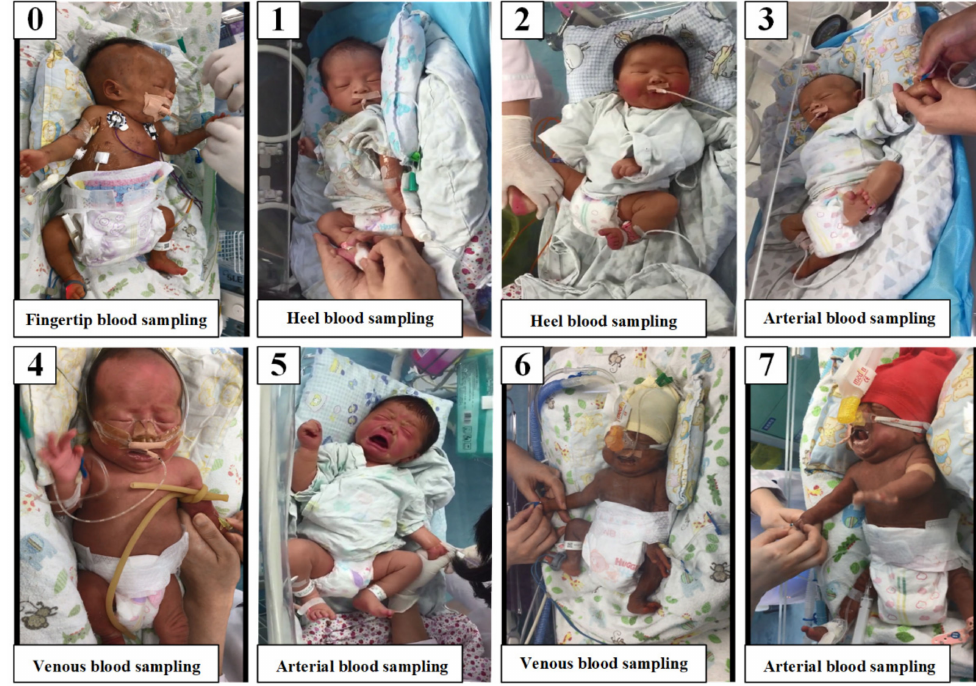
Figure 4. Samples of neonatal pain data with different blood-sampling operations and pain scores.